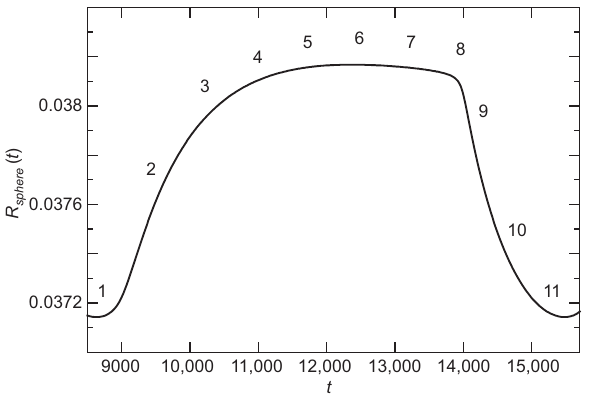
( t ) defi ning a sphere